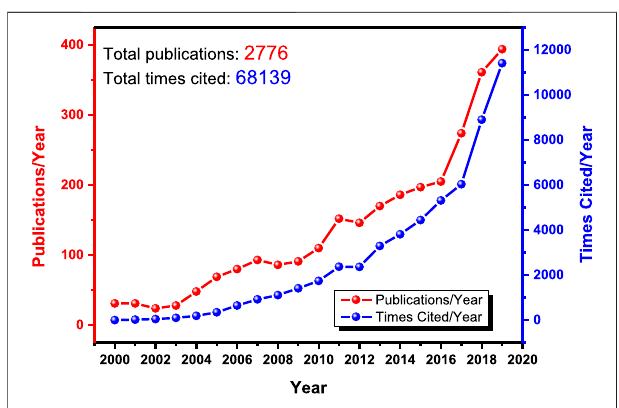
FIGURE2| Publicationsand timescited peryearwith “ superabsorbent ” as a keyword, based on the Web of Science Core Collection.